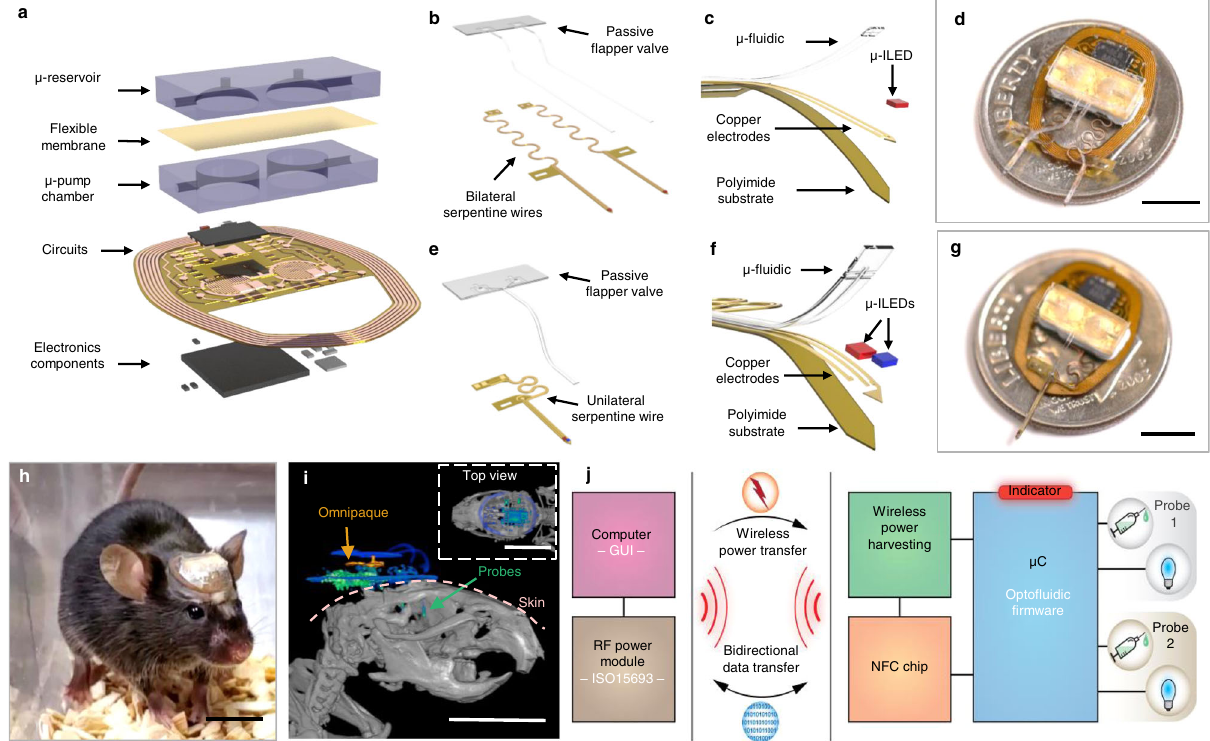
Fig. 1 | Wireless, battery-free multi-lateral microsystems for programmable pharmacology and optogenetics. a Diagram illustration of the system. b , c and e , f Magni fi ed views of the bilateral and unilateral neural probes with optical ( µ - ILED) and fl uidic delivery. d and g Photographic images of the front side of both bilateral and unilateral bi-channel devices. Scale bar: 0.5cm. h Photos of the